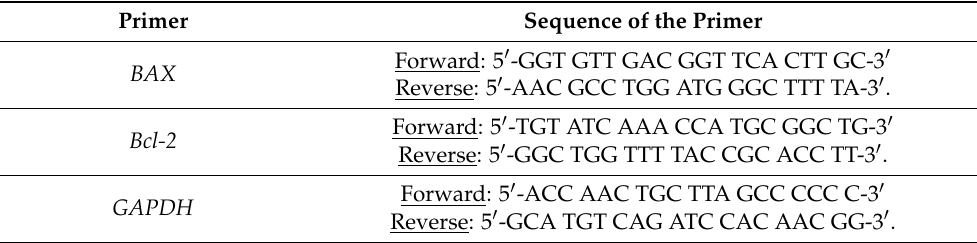
Table 1. Primers sequences used in